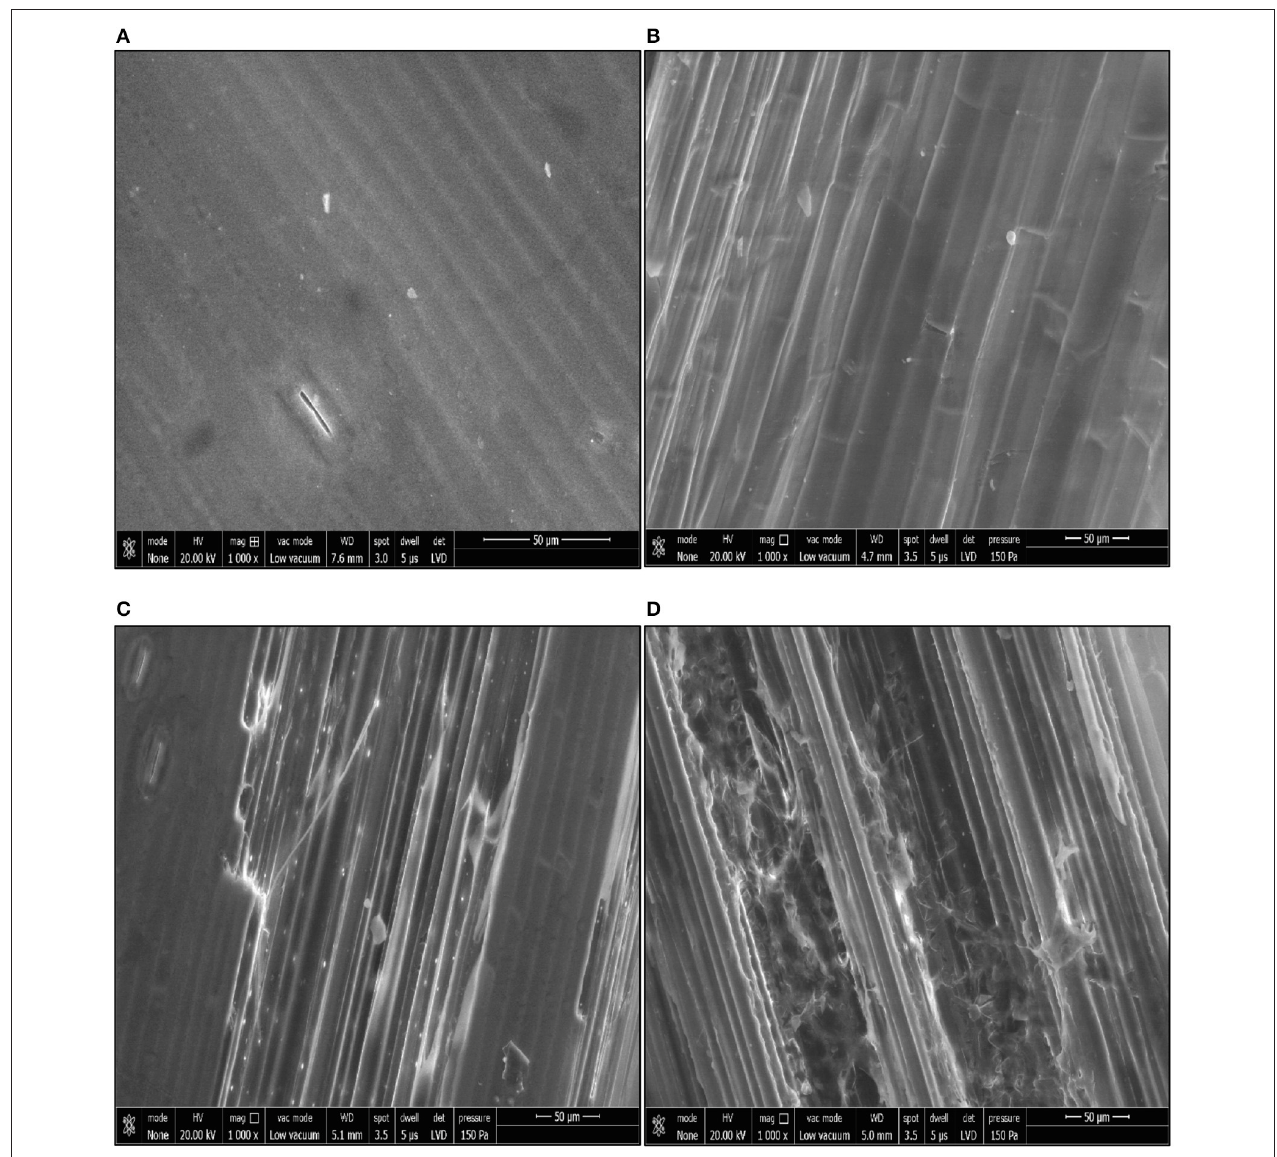
FIGURE 7 | The SEM images of (A) Untreated WS, (B) WS-30, (C) WS-60, and (D)